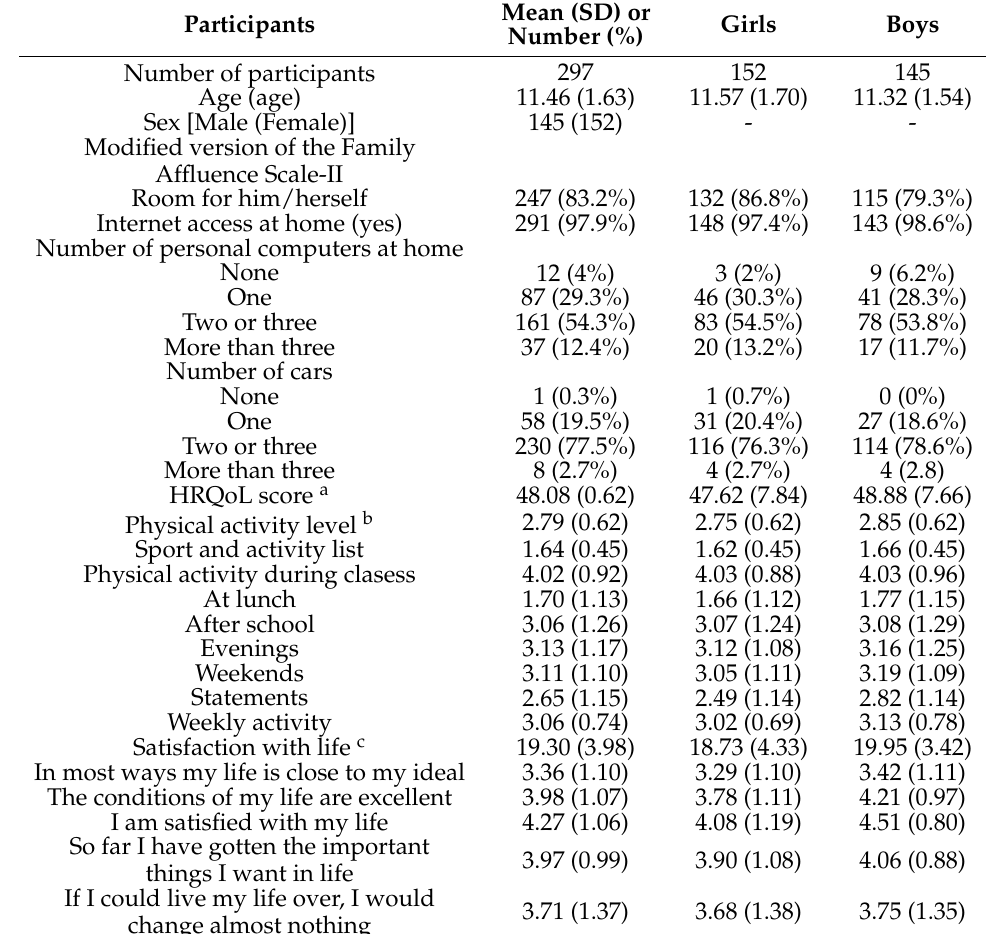
Table 1. Descriptive characteristics of